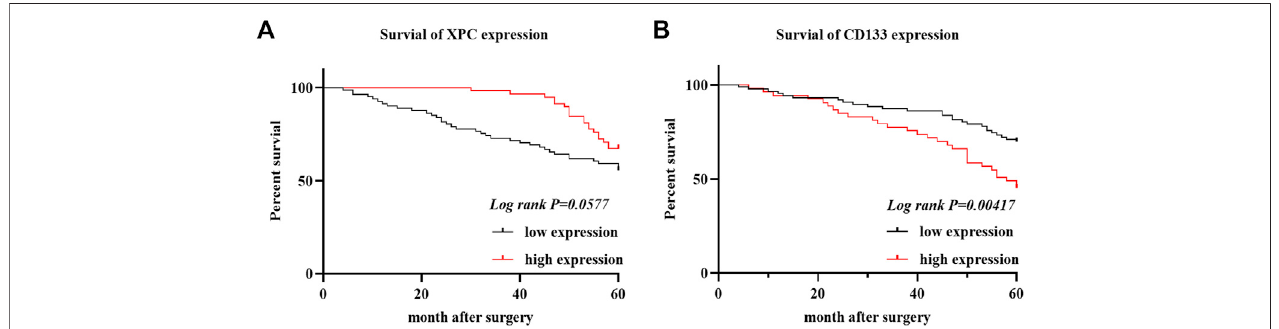
FIGURE 3 | XPC and CD133 Kaplan Meier curve. (A) . Obtain the OS of 140 cases of lung adenocarcinoma from the HIS system, divide the expression of XPC in 140 cases of lung adenocarcinoma into two groups: XPC high expression and XPC low expression, and use Graphpad Primes 8 to analyze the survival of XPC in lung adenocarcinoma. Kaplan Meier curve found that, compared with the low XPC expression, the high XPC expression is related to the better prognosis of lung adenocarcinoma( Log-rankp (cid:1) 0.0577). (B) .DividetheexpressionofCD133in140casesoflungadenocarcinomaintotwogroups:highexpressionofCD133and lowexpressionofCD133.GraphpadPrimes8wasusedtoanalyzethesurvivalofCD133inlungadenocarcinoma.KaplanMeiercurvefoundthatcomparedwiththehigh expression of CD133, CD133 was low. The expression is related to the better prognosis of lung adenocarcinoma ( Log-rank p (cid:1)